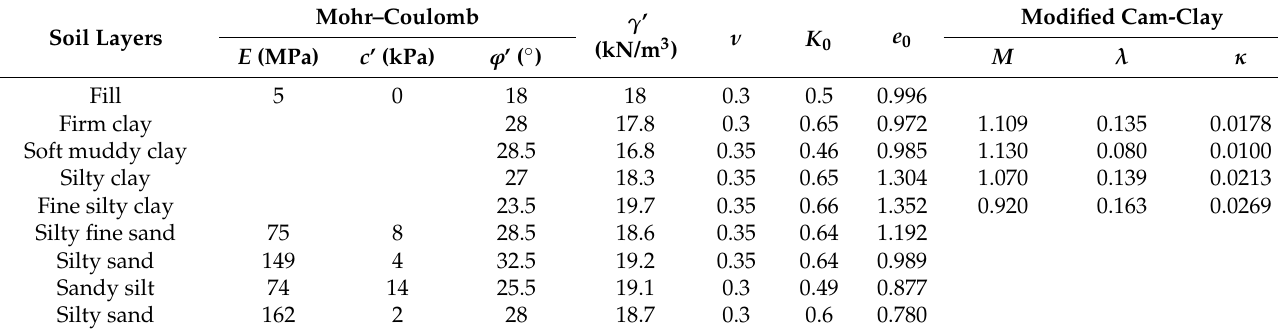
Table 1. Input parameters of the layered